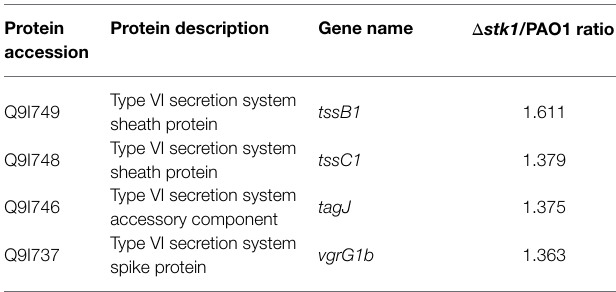
TABLE 3 | The differentially expressed T6SS-H1-related proteins in the Δ stk1 strain compared with the PAO1 strain. Protein Protein description accession